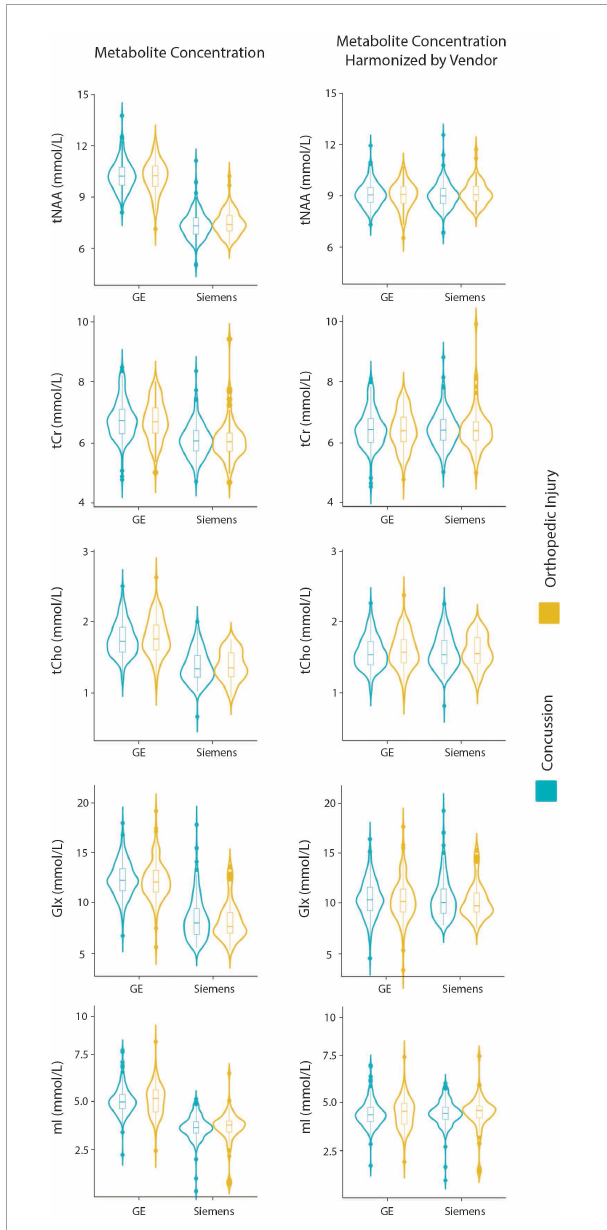
FIGURE1 Violin plots showing metabolite concentrations pre- and post-ComBat harmonization by vendor (GE and Siemens) for tNAA, tCr, tCho, Glx, and mI. The data are separated by the two clinical groups: concussion and orthopedic